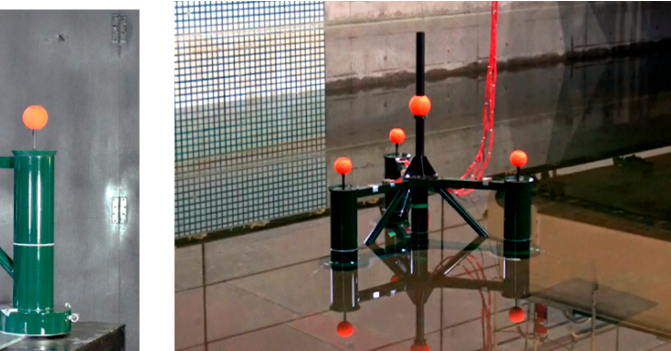
Pitch Figure 7. Natural periods of motion. The dynamic responses of the platform in the regular waves are characterized by RAOs, in which the amplitudes of platform motion and mooring tension are normalized by the wave amplitudes as RAOs= (15) where A is the amplitude of dynamic response for the platform motion, mooring ten- sion and sectional loads, and H refers to the incident regular wave height.